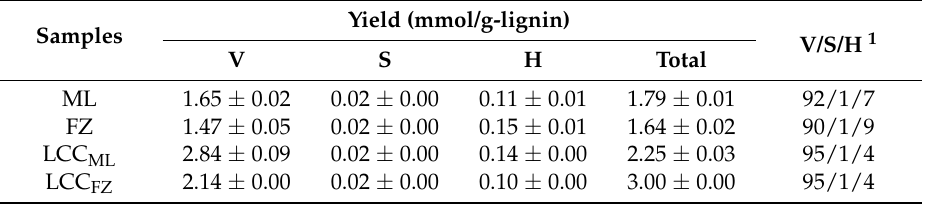
Table 6. The yield and ratio of nitrobenzene oxidation products of ginkgo shells and LCCs.